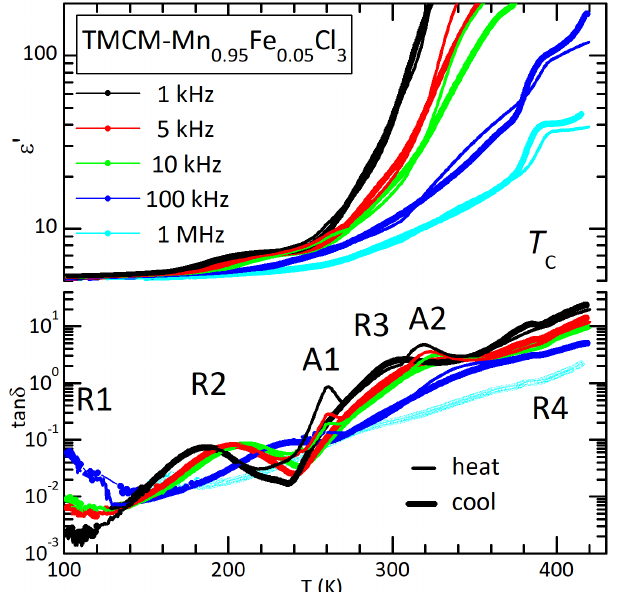
Figure 2. Dielectric permittivity of TMCM-Mn 0.95 Fe 0.05 Cl 3 measured during cooling (thick) and subsequent heating (thin) at the frequencies indicated in the legend. The labels R n indicate thermally activated dielectric relaxations, while A n indicate anomalies of other